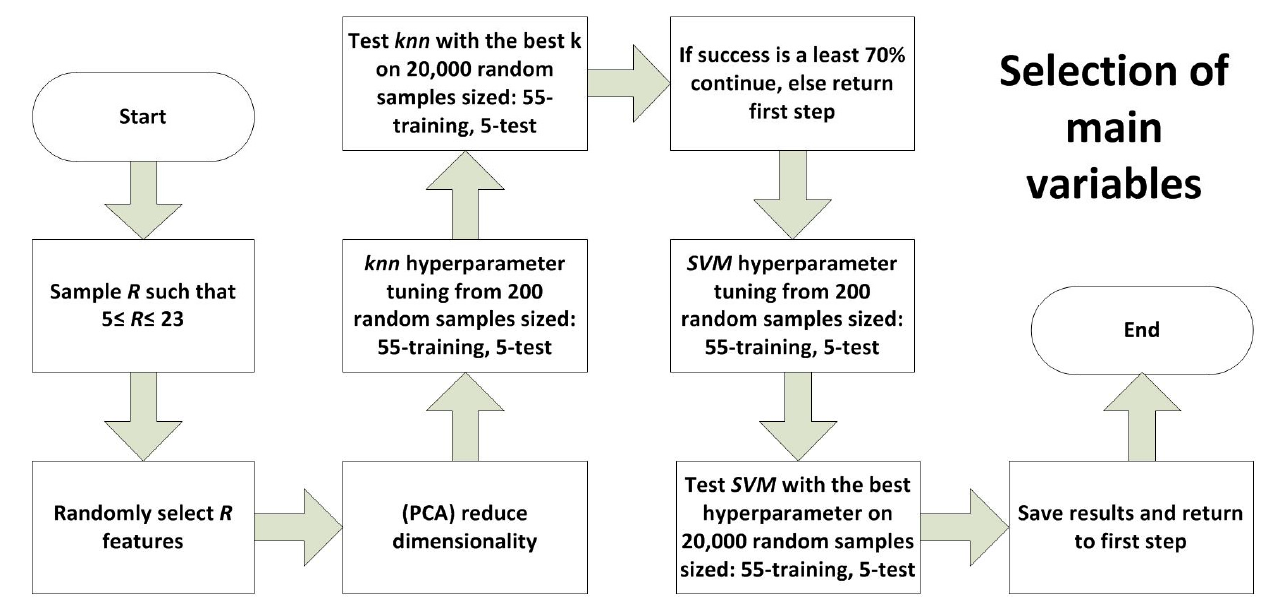
Figure 4. Proposed methodology for the selection of main variables.